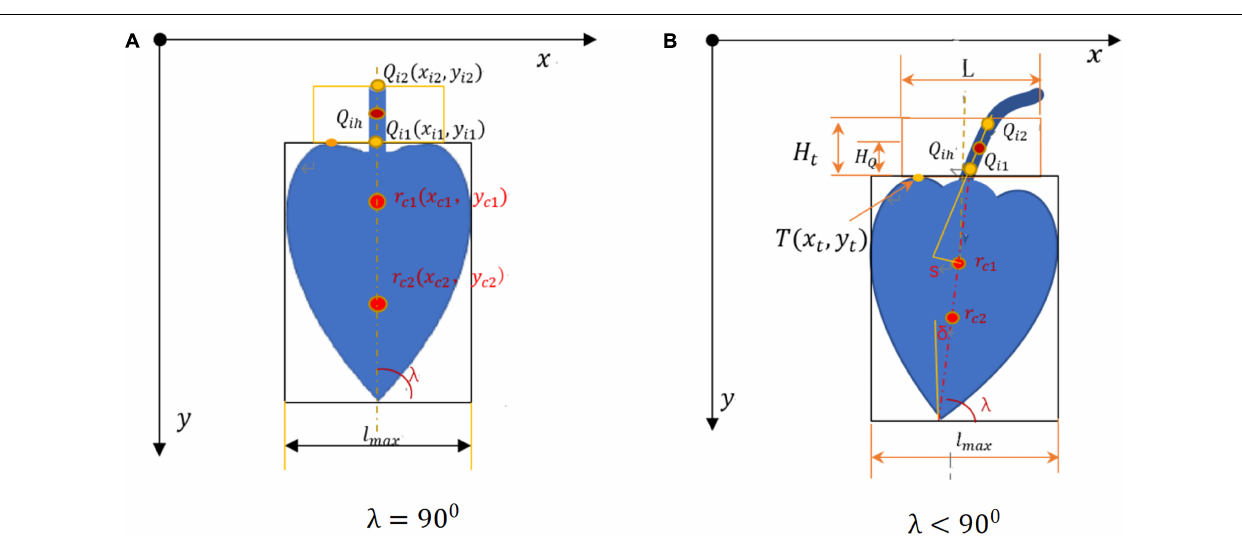
FIGURE 7 | Schematic for solving image centroid and cutting point. (A) = 90 0 . (B) = 90 0